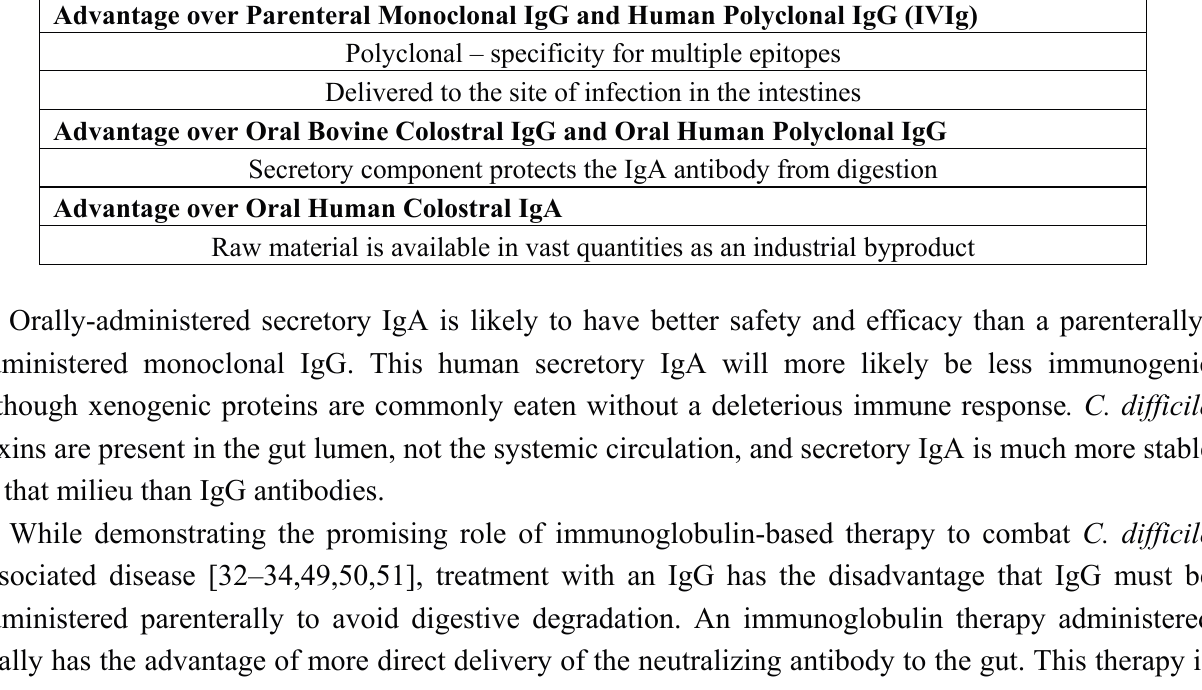
Table 1. Potential Advantages of Oral Human Secretory IgA for the Treatment of C. difficile Infection. Advantage over Parenteral Monoclonal IgG and Human Polyclonal IgG (IVIg) Polyclonal – specificity for multiple